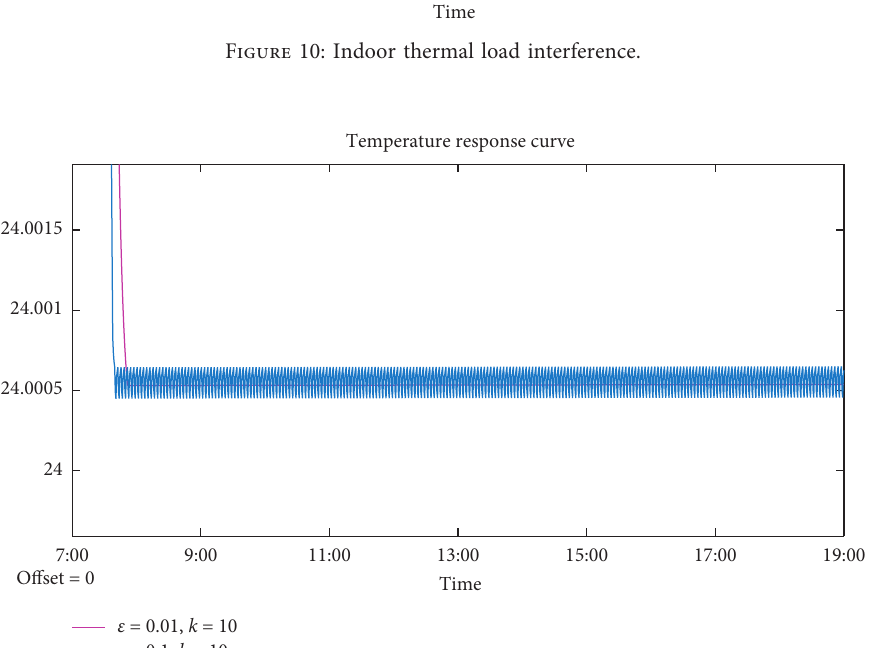
Figure 11: Temperature response curve with ε � 0.1, k � 10 and ε � 0.001, k �